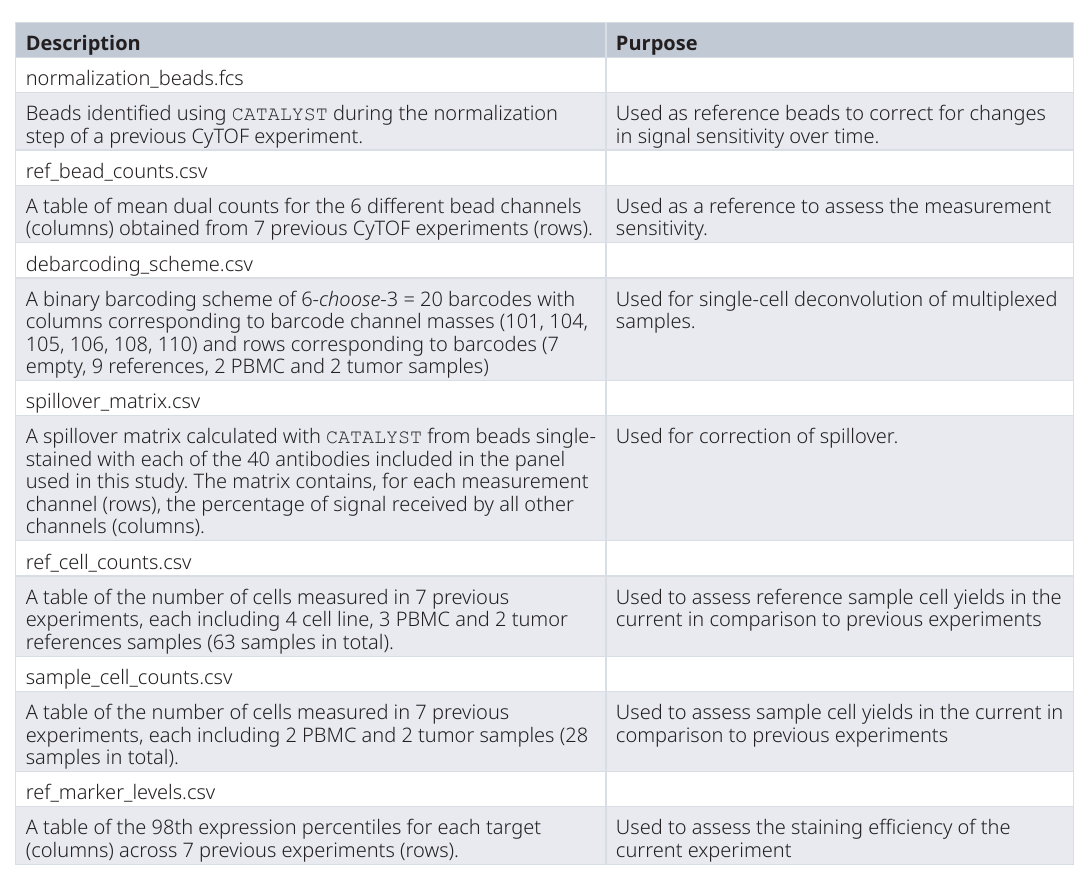
Table 1. Overview of metadata files used throughout this pipeline, including each file’s description, dimensionality (if appropriate), and purpose for preprocessing or quality